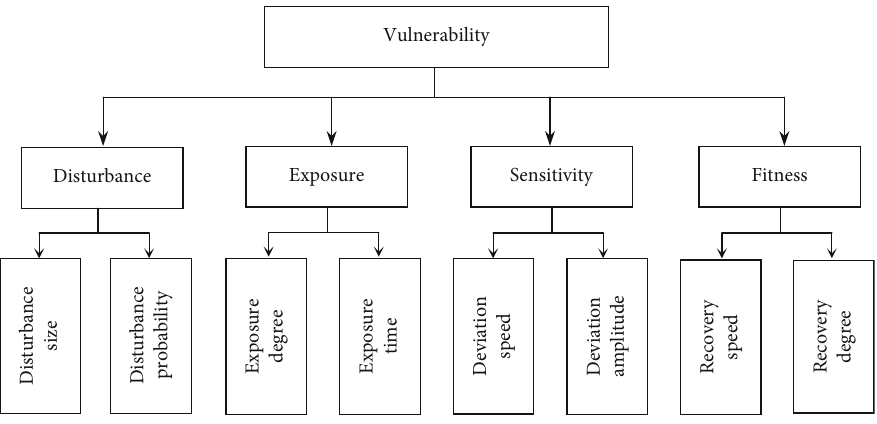
Figure 3: Vulnerability assessment index system.